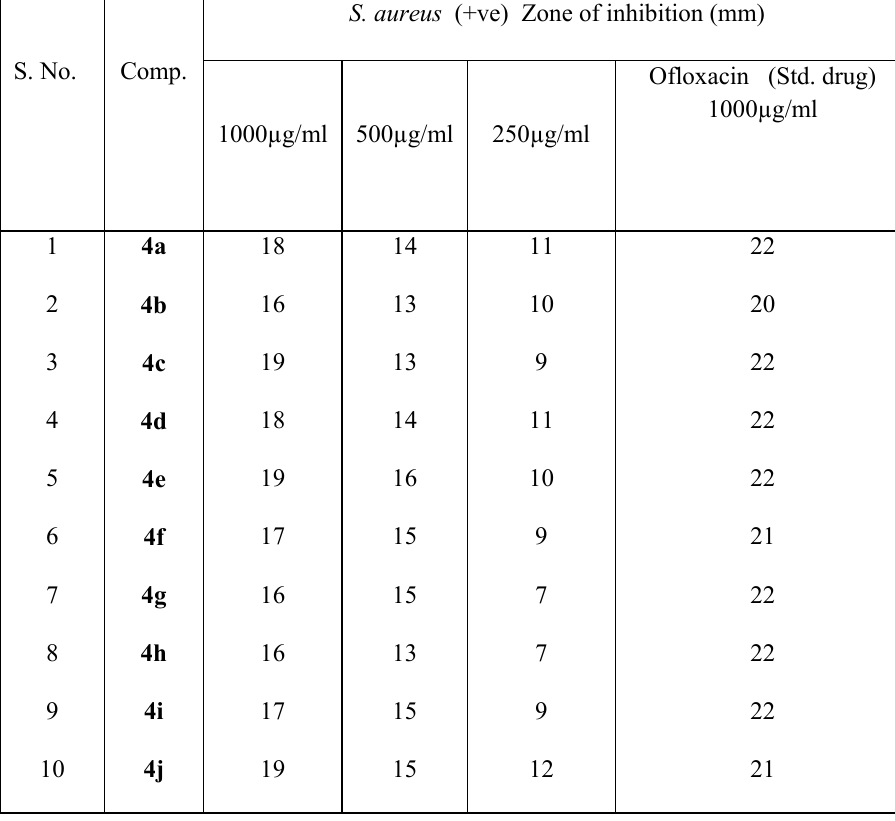
Table 2. Anti –Bacterial Activity of 1, 3, 4-thiadiazole derivatives against S. aureus.